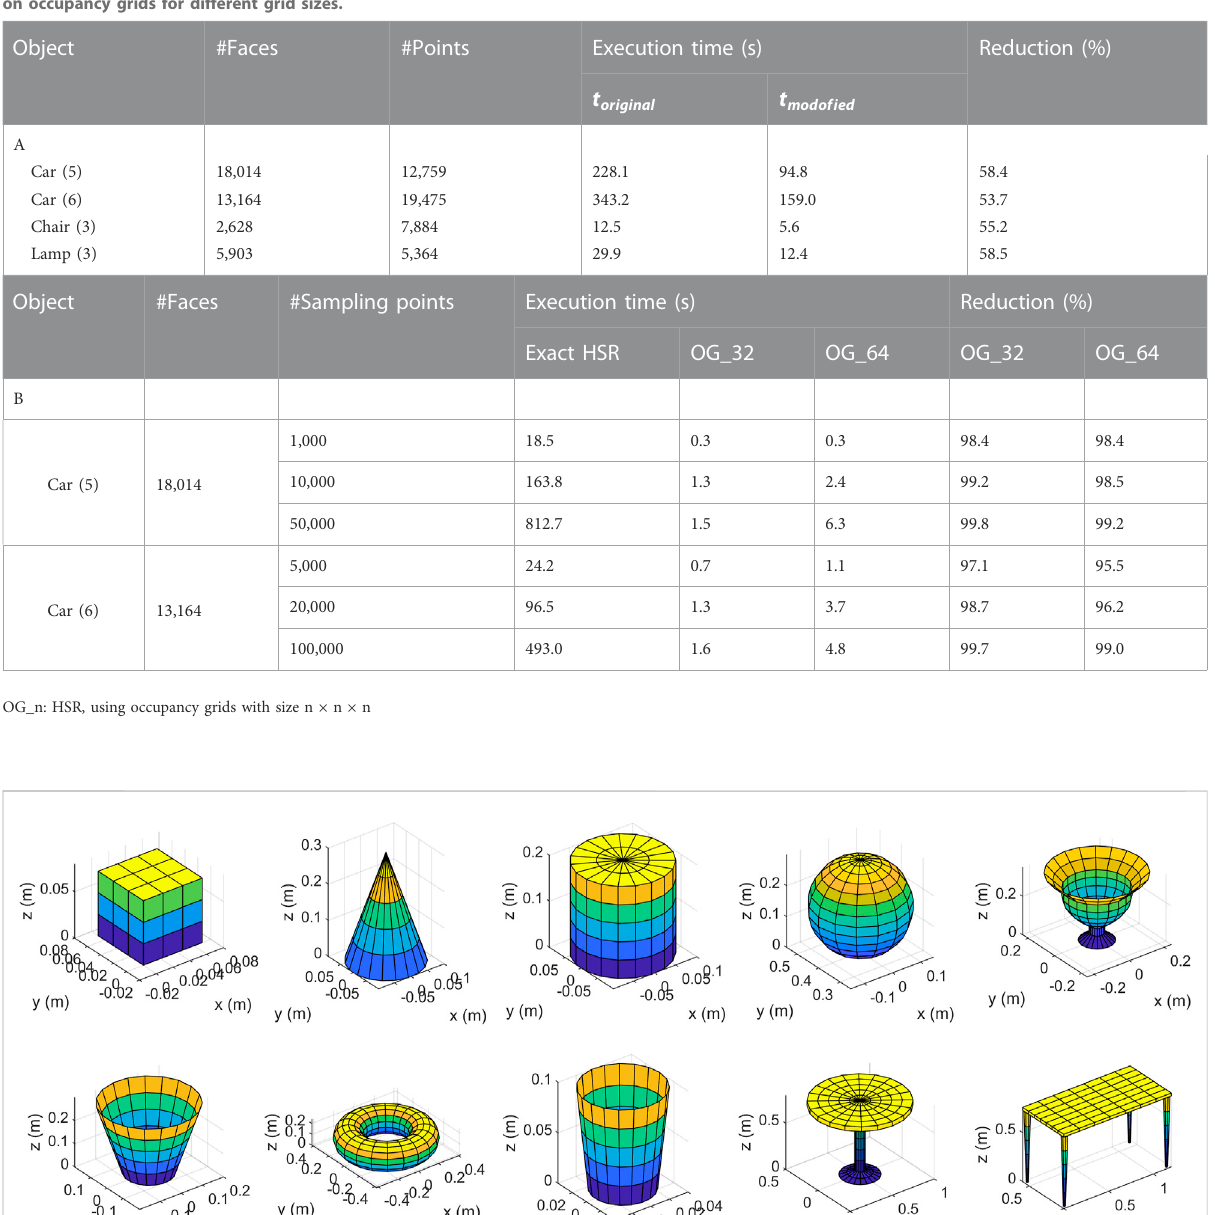
TABLE1(A)Comparisonoftheexecutiontimeoftheoriginalandmodi fi edHSR,(B)ComparisonofexecutiontimebetweenexactHSRandmodi fi edHSRbased on occupancy grids for different grid sizes.